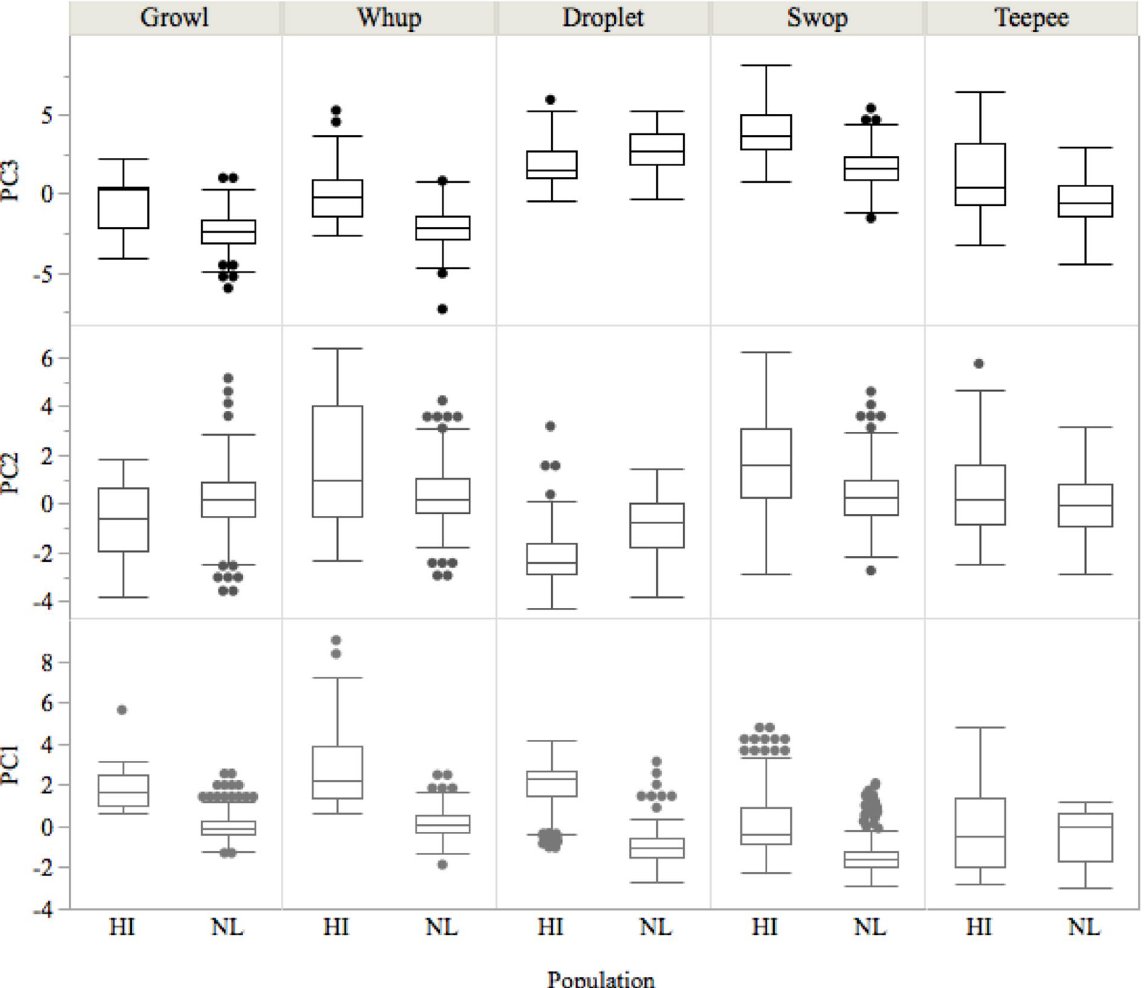
Figure 3. PC1, PC2, PC3 by call type and population showing between-population variation in acoustic parameters within call types as well as variation among call types. Boxplots show the mean (middle horizontal bar), 25th percentile (lower bar), 75th percentile (upper bar), and outliers. Positive PC1 values refer to calls of higher frequency and shorter duration, while negative PC1 values refer to calls of lower frequency and longer duration. Positive PC2 values refer to calls with a larger range in frequency and higher entropy, while more negative PC2 values refer to calls with a smaller frequency range and lower entropy. Positive PC3 values refer to calls with more variation in frequency and amplitude, while more negative PC3 values refer to calls with less amplitude and frequency